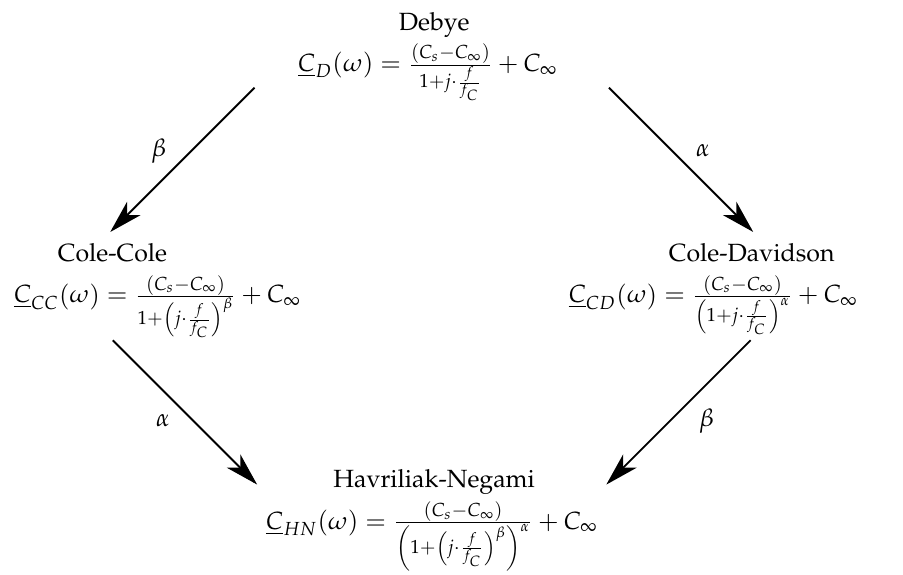
Figure 5. Relationship between dipole relaxation models